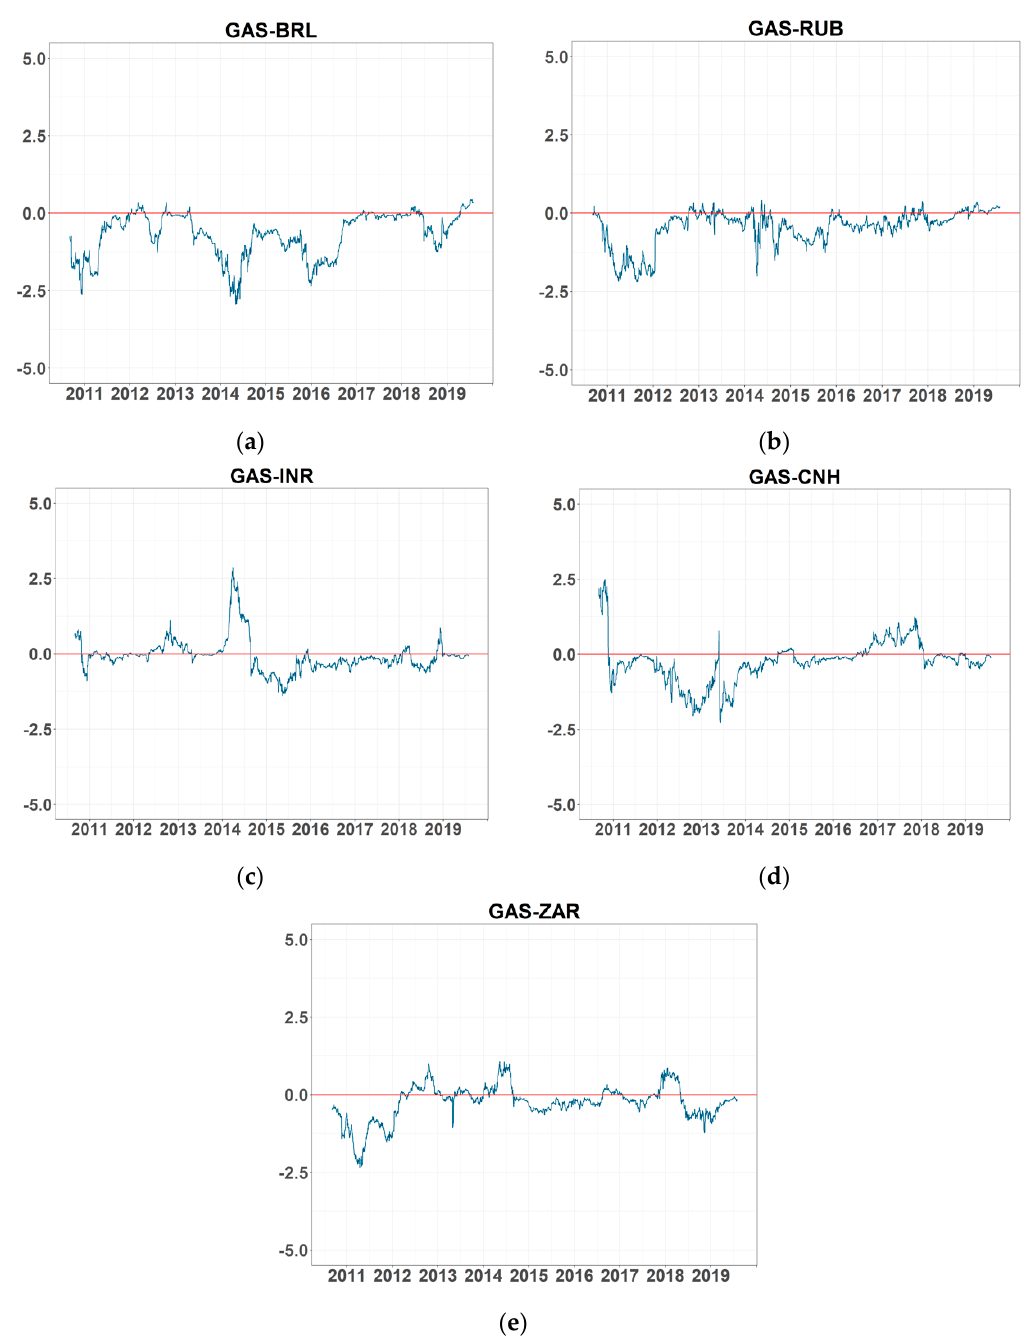
Figure 5. Net pairwise connectedness of return series. ( a – e ) refer to the net pairwise connectedness between GASF and BRL, RUB, INR, CNH, and ZAR return series, respectively. Note: BRL, RUB, INR, CNH, and ZAR are Brazilian Real, Russian Ruble, Indian Rupee, o ff shore Chinese Yuan, and South African Rand, respectively. GASF is the Henry Hub natural gas futures